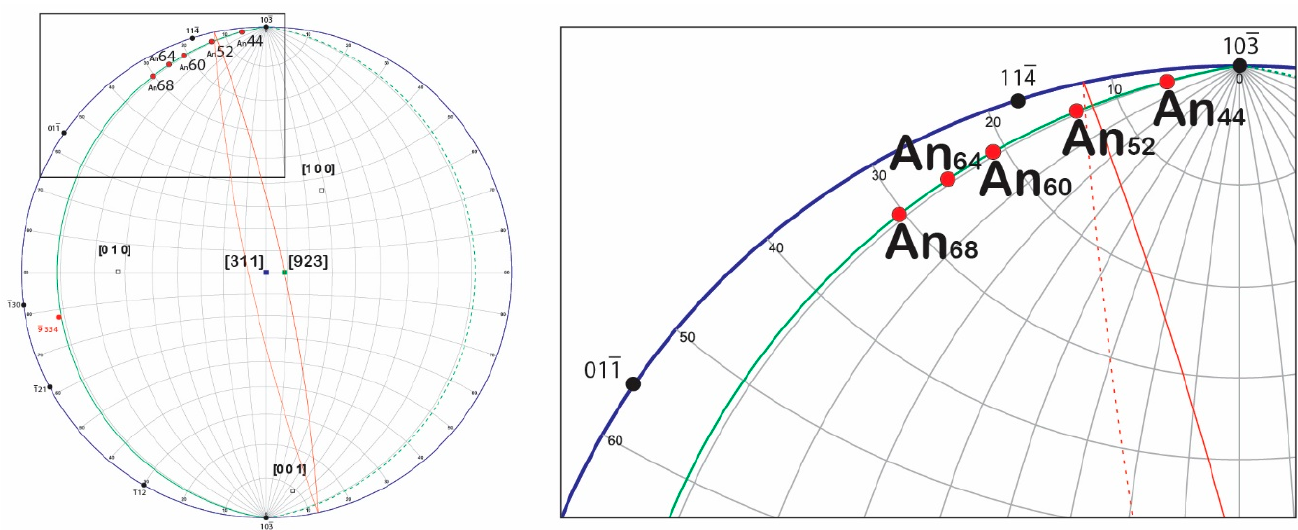
Figure 2. Stereonet projection of the modulation vectors along with the exsolution lamellar orientation, viewing along the [311] axis. The modulation vectors are averaged from the data of the e α structures in Jin et al. [23]. The modulation vector moves on the [923] zone axis away from (103(cid:3364)) about 1° for every 1 mol% more An in composition.